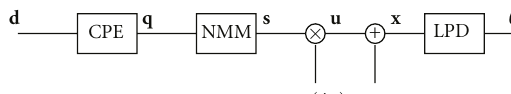
Figure 2: Phase space